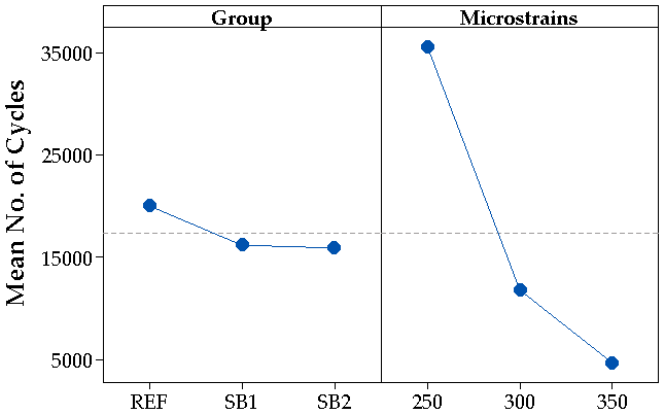
Figure 8. Main effects plot for fatigue resistance (mean number of cycles).